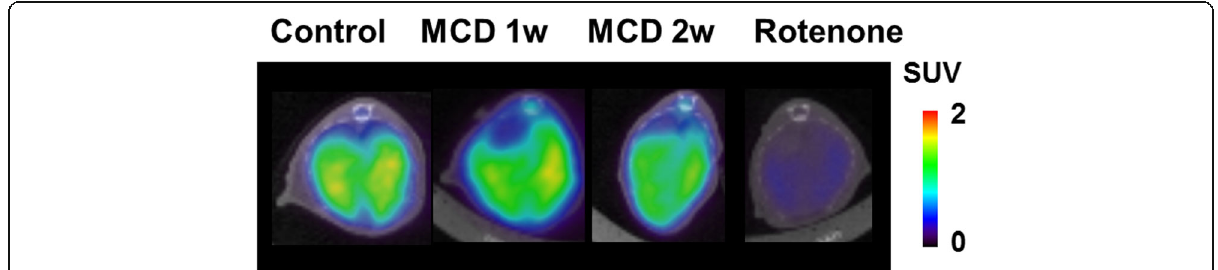
Fig. 4 Representative PET/CT fusion images in the livers of mice fed a control or methionine- and choline-deficient (MCD) diet. Inhibition studies were performed by pre-injection of rotenone (1 mg/kg) into control mice 20 min before 18 F-BMS infusion